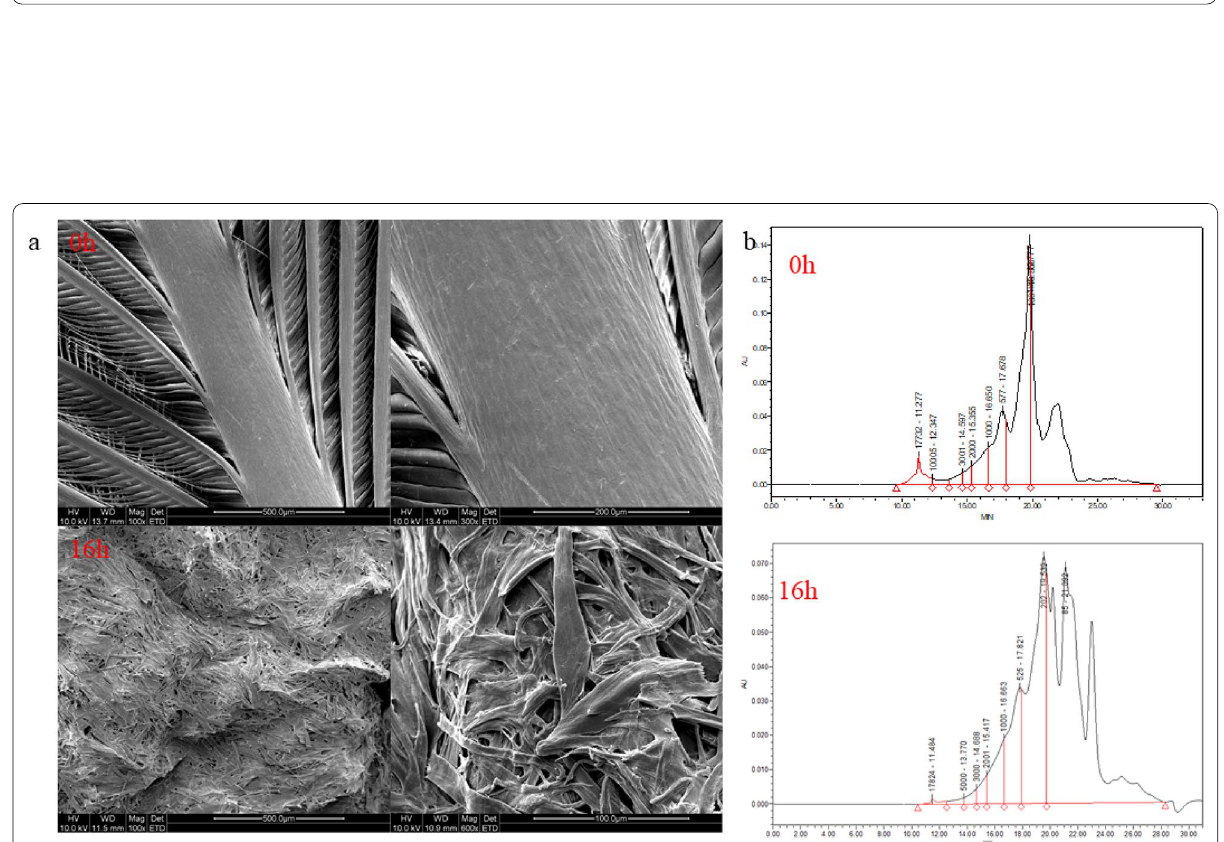
Fig. 6 Optimization of compound enzyme conditions. a Proportion of compound enzyme (trypsin: keratinase); b compound enzyme addition level; c temperature; d pH; e time; f sulfite addition amount